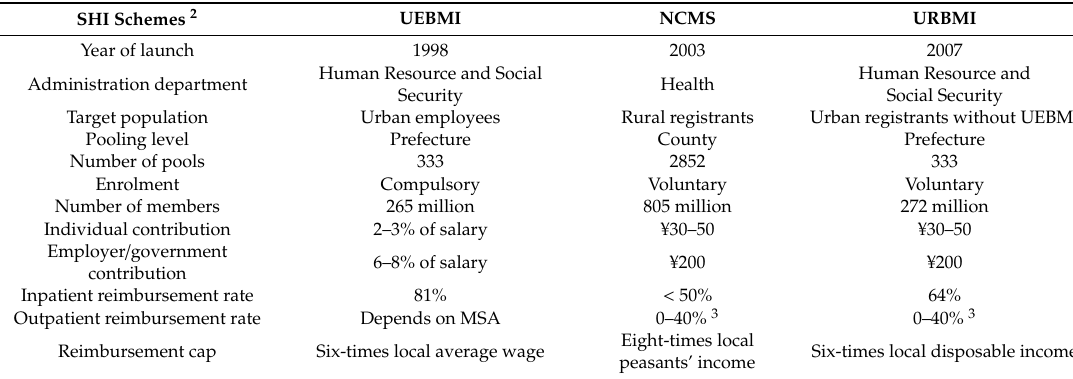
Table 1. Summary of China’s social health insurance institutions 1